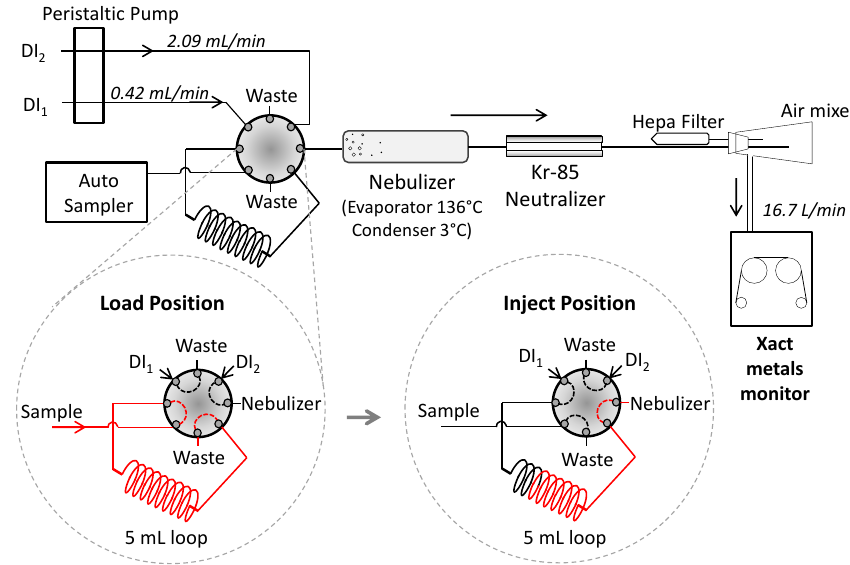
Figure 1. Schematic of automated system developed to measure elements in the water-soluble aerosol extracts using an online XRF element analyzer (Xact TM